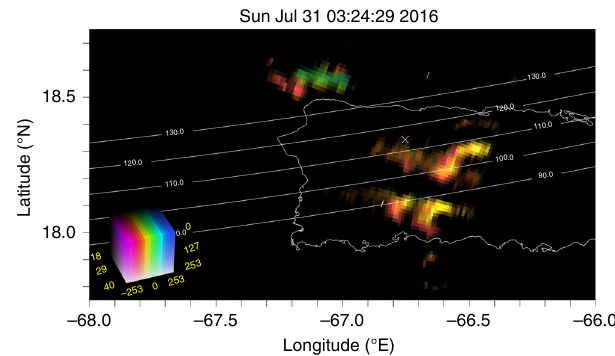
Fig. 4 Representative images of radar echoes due to coherent scatter from plasma density irregularities in E s layers near 110-km altitude at 2324.5 LT. The brightness of the image pixels speci fi es the echo signal-to-noise ratio on a decibel scale. The hues re fl ect Doppler velocity, with red (blue) hues denoting drifts away from (toward) the radar located on St.